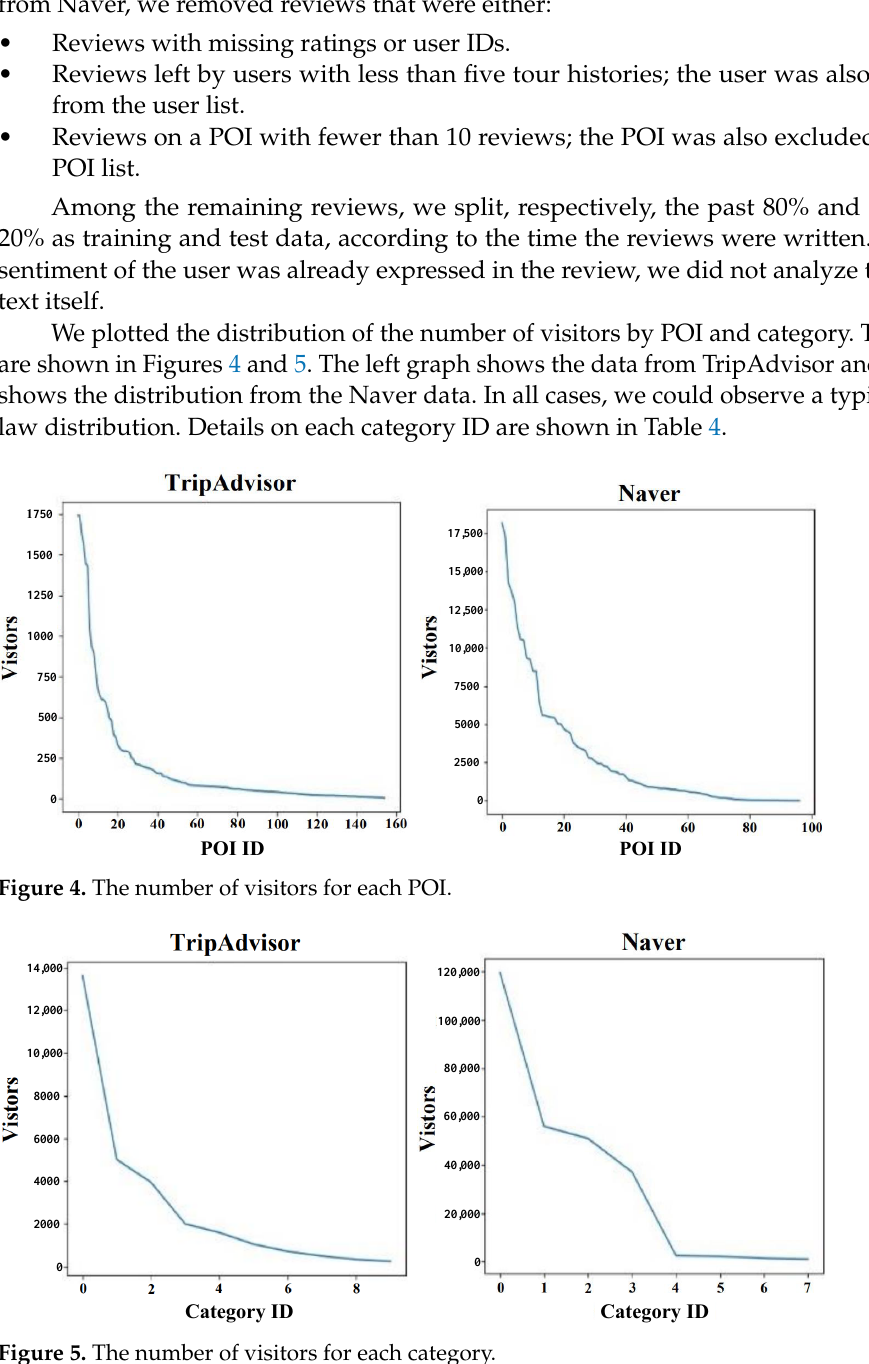
Figure 5. The number of visitors for each